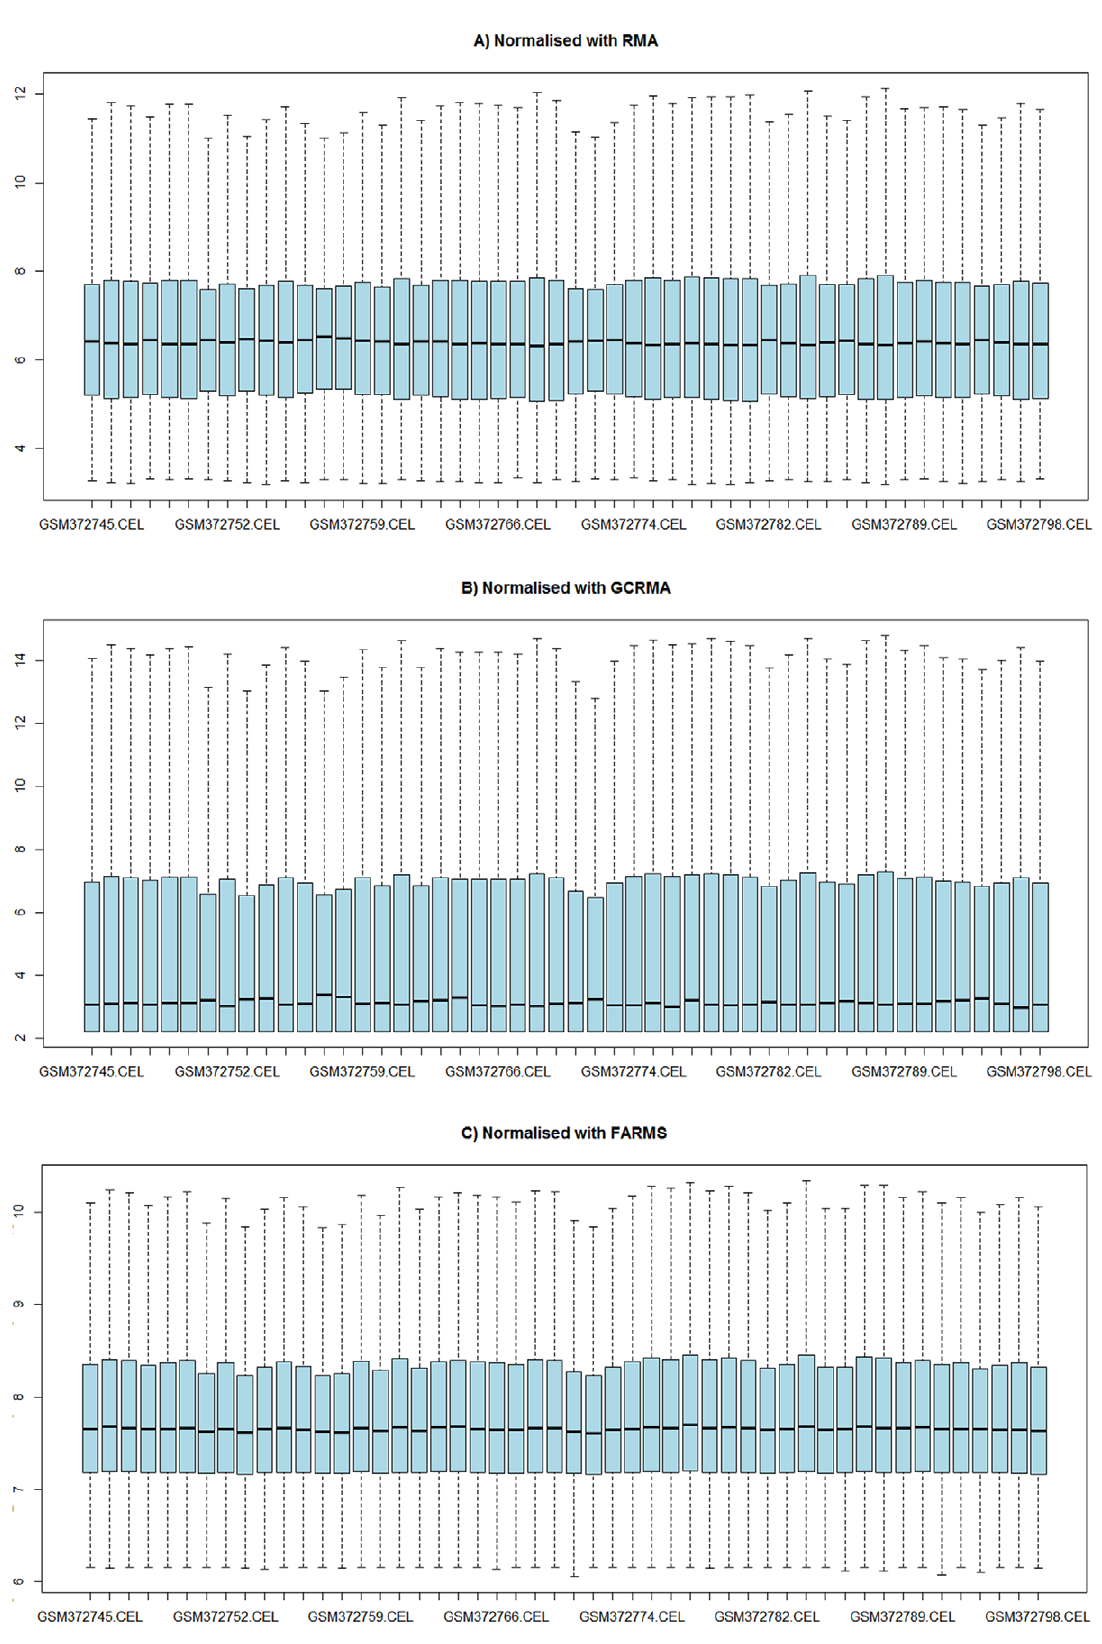
Figure 1. Boxplots of the log2 transformed data normalised using A) rma, B) gcrma, and C) farms.